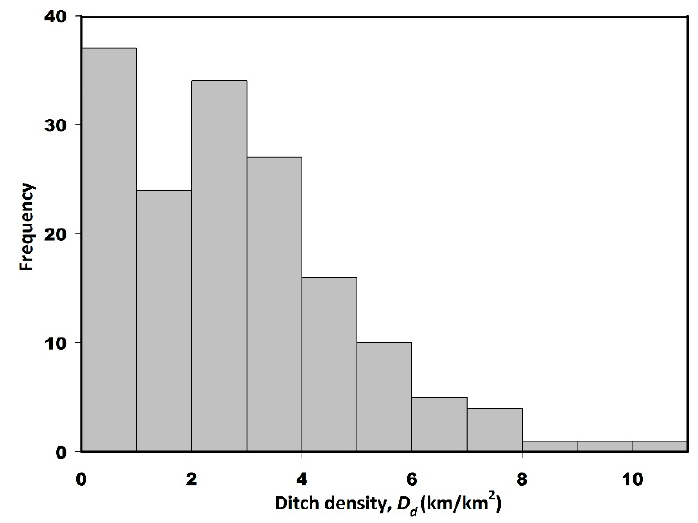
Figure 3. Histogram of ditch densities ( D d ) in peatland patches; two modes existed in the 0 to 1 and 2 to 3 km/km 2 ranges.